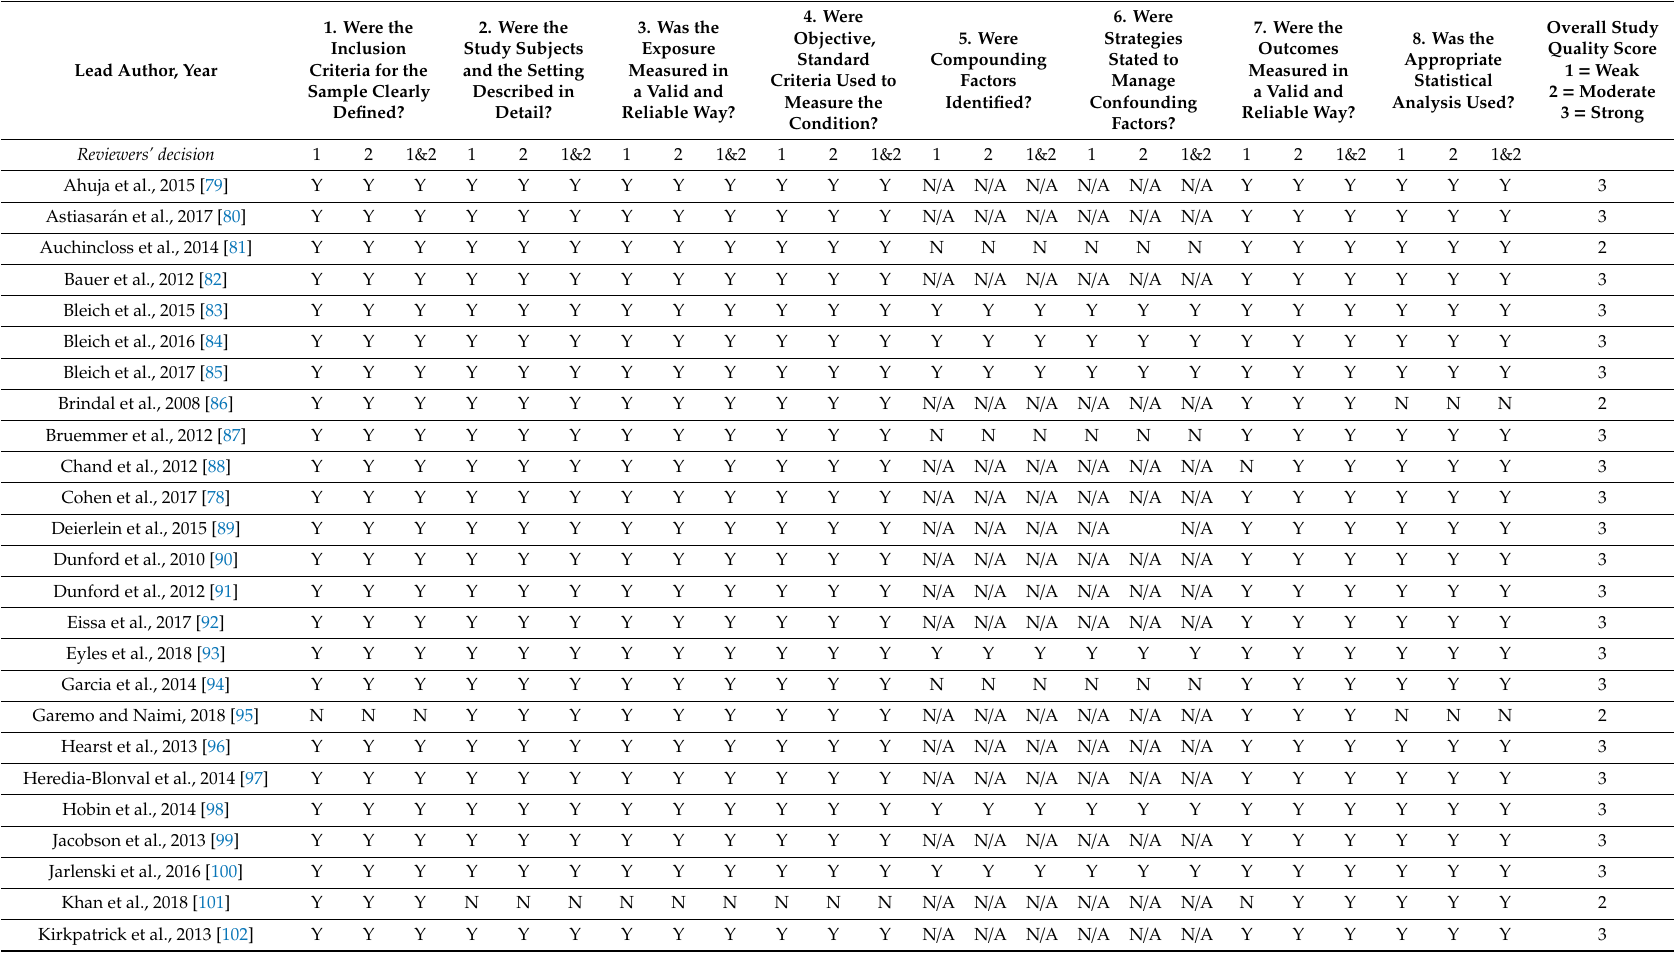
Table 4. Evaluation of study quality assessed by the Joanna Briggs Institute critical appraisal